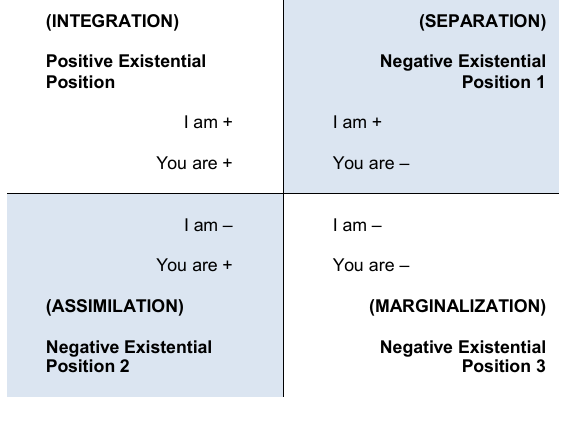
Figure 2: Scheme of the Conceptual Congruence among the Existential Positions and the Styles of